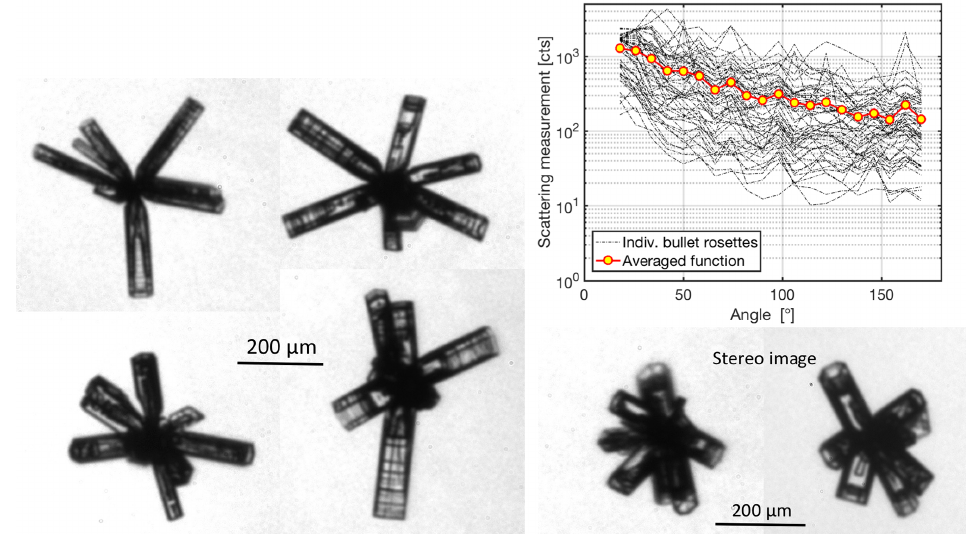
Figure 14. Examples of hollow bullet rosettes selected from the imagery captured by PHIPS-HALO during the descent through a cirrus cloud of ∼− 45 ◦ C over Nebraska. Measured single particle angular light scattering functions automatically assigned to the selected hollow bullet rosettes (right, dashed-dotted lines). The habit-specific averaged angular scattering function of this particle class is given in red.